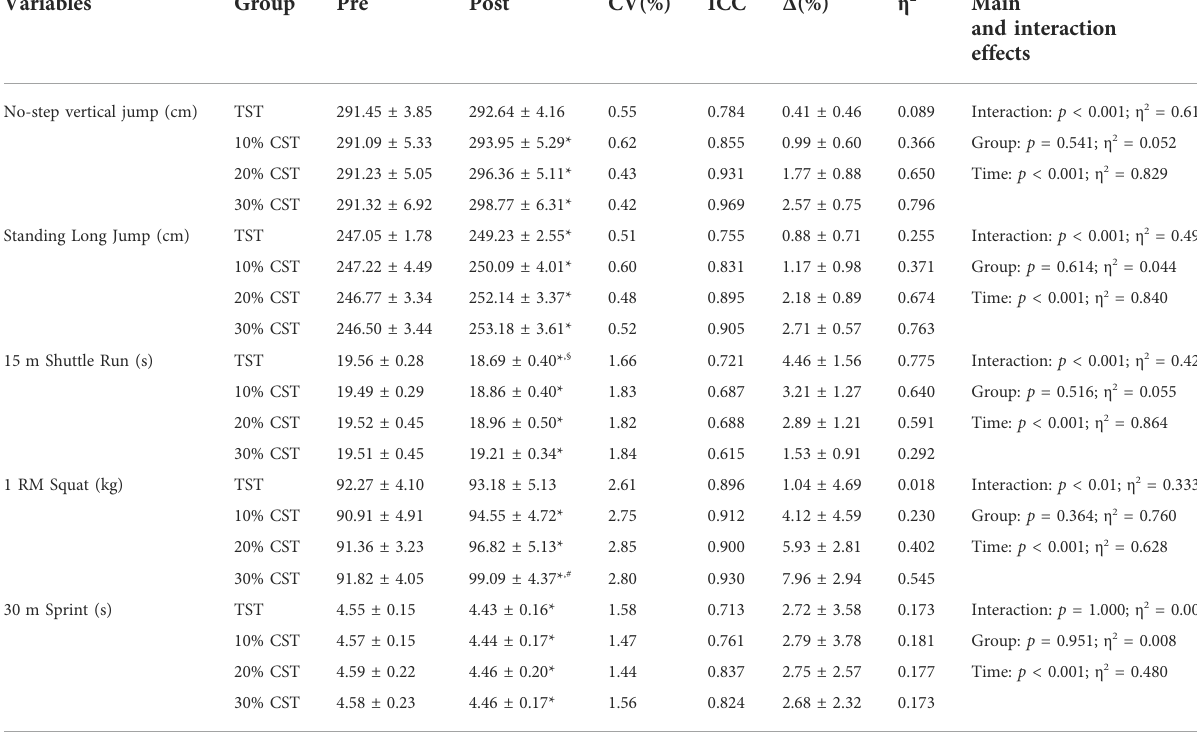
TABLE 2 Descriptive statistics (mean ± SD), percentage changes ( Δ %), and effect size (ES) in fi ve lower limb explosive power variables pre and post- intervention between groups. Variables Group Pre